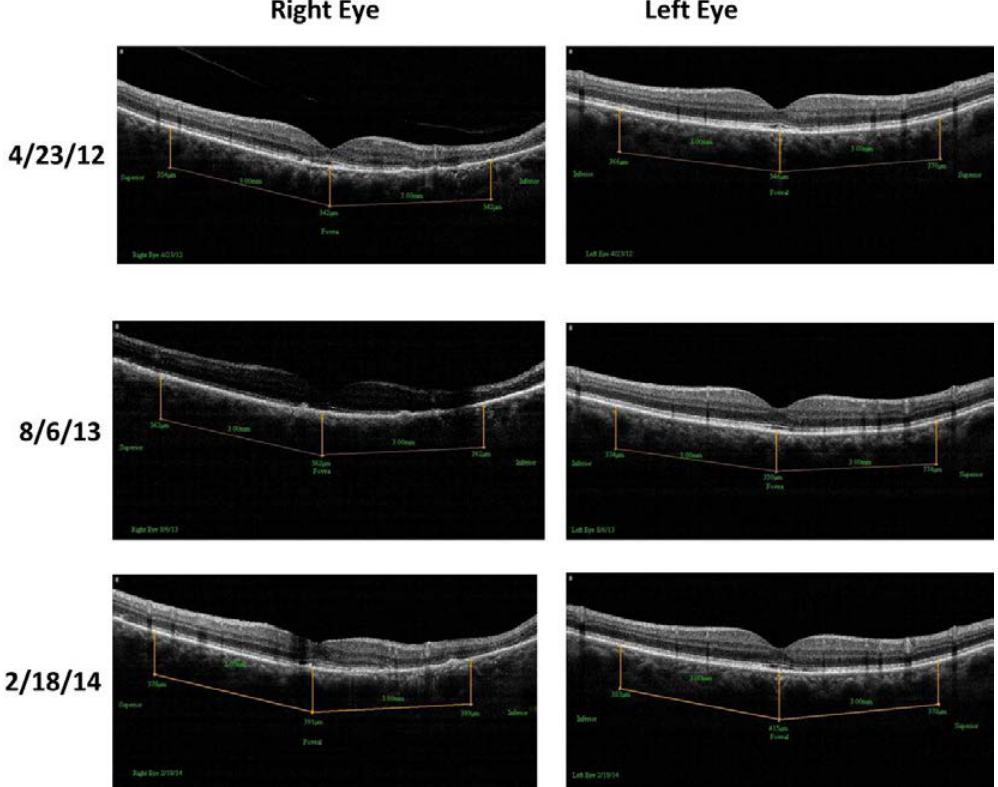
Figure 10. SDOCT “Extended Depth Imaging” of Choroidal Thickness (microns) of a 67-year-old male patient with PCV, an AMD treatment resistant variant. Choroidal thickness (in microns) increased 12% difference right eye and 7% difference left eye by 18 months. This represents additional choroidal thickening, well above the 5.0-micron axial resolution of the OptoVue RTVue ® SD OCT. Better clinical perfusion of the posterior retina is presumed.